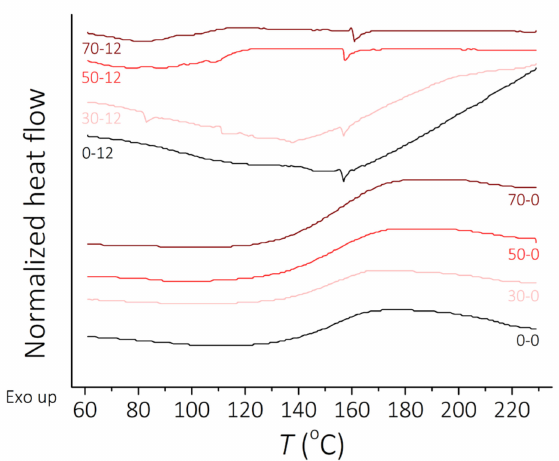
Figure 3. DSC curves, heat flow vs. temperature. Curves for the second heating before incubation and after 12 weeks of